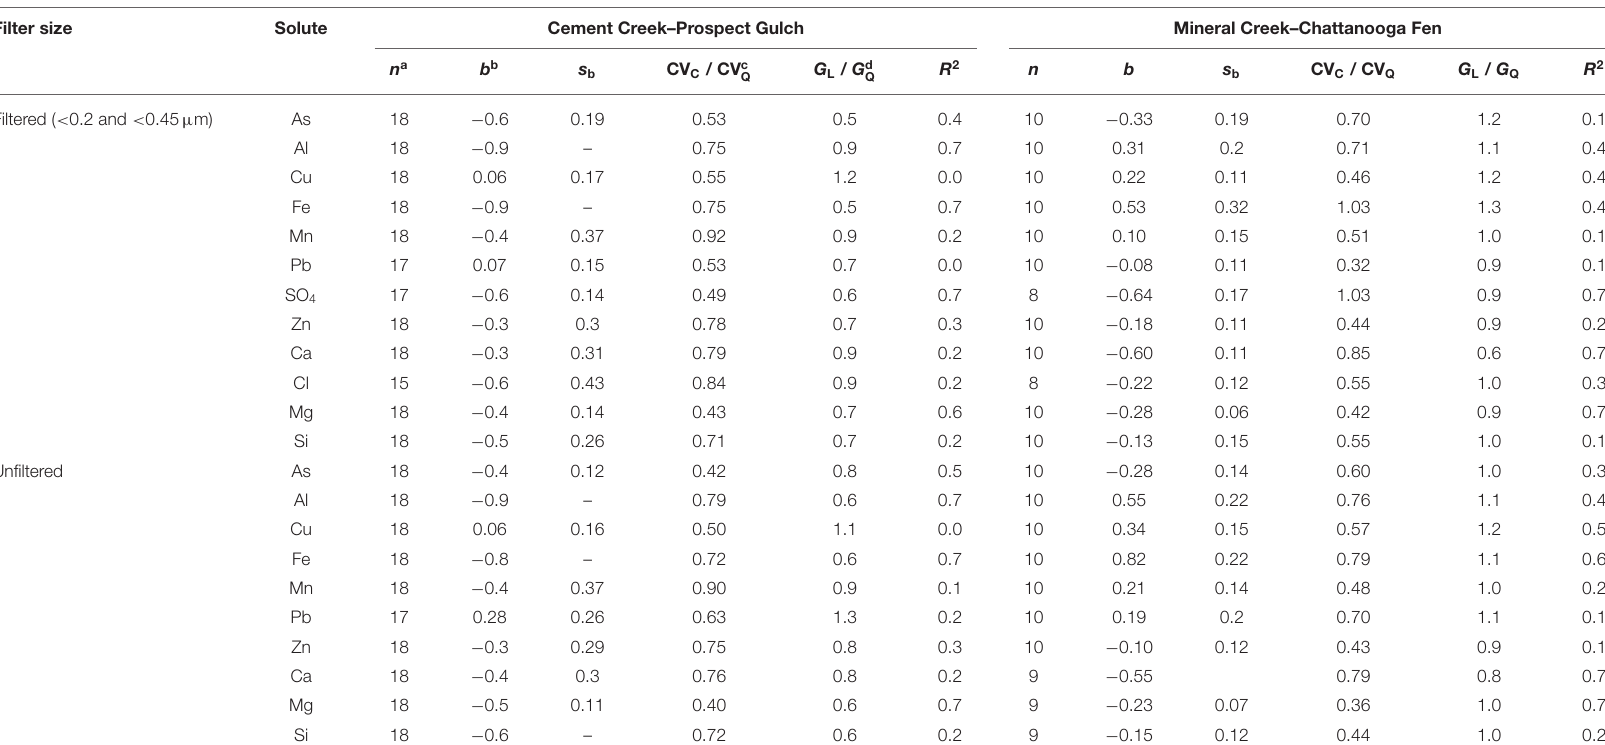
TABLE 6 | Power law slopes ( b ) for concentration–discharge relationships for Mineral Creek and Cement Creek at two locations, including the standard error of the slope ( s b ), coefficients of variation (CV), and Gini coefficients for concentration ( G L ) normalized to the Gini coefficient for discharge ( G Q ). Filter size Solute Cement Creek–Prospect Gulch